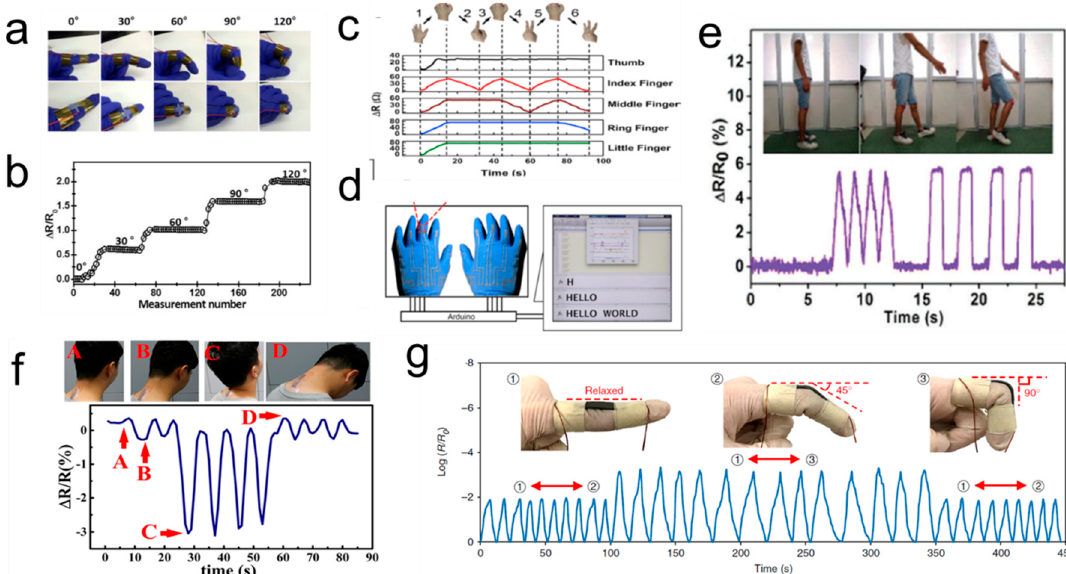
Figure 7. Liquid metal-based strain sensors. ( a , b ) Finger motion detection using strain sensors and its corresponding resistance change [95]. Copyright (2019) American Chemical Society. ( c ) Motion monitoring of five fingers with slow bending and straightening. ( d ) Use wearable gloves for typing “HELLO WORLD” [96]. Copyright (2018) the author(s). ( e ) A highly flexible strain sensor monitors knee motion [62]. Copyright (2013) Royal Society of Chemistry. ( f ) Real-time monitoring of necks motions by strain sensor consisting of liquid metal micro particles [95]. Copyright (2019) American Chemical Society. ( g ) Unusual resistance changes of the strain sensors under cyclic bending [56]. Copyright (2019) Springer Nature.